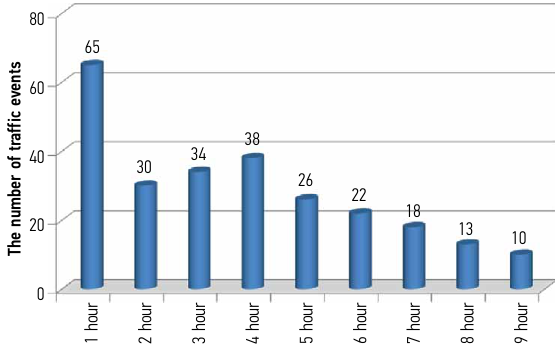
Fig. 3. The dependence of the number of traffic events on the number of the driver’s working